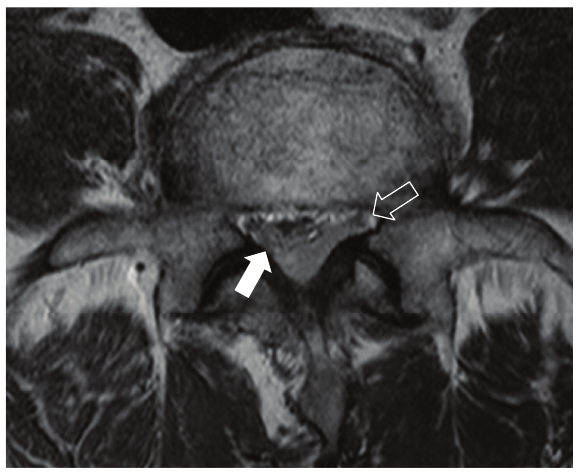
Figure 2: Axial T2-weighted image in upper body level of L5 reveals compression of thecal sac (solid arrow) and left S1 nerve root (open